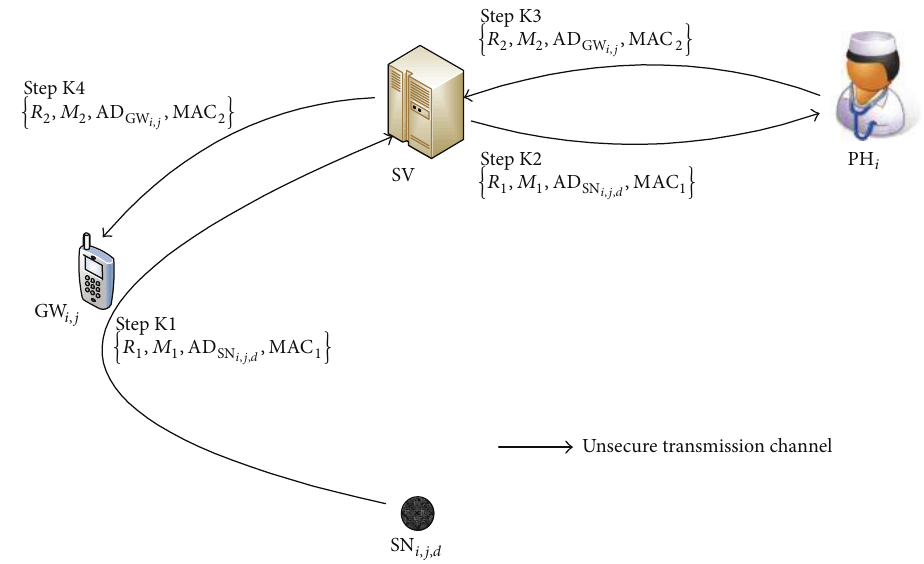
Figure 3: Noninteractive key agreement and secure communication in Kim’s paper